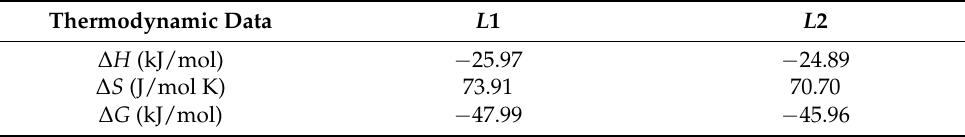
Figure 7. D U by two ligands in n-dodecane as a function of temperature ([HNO 3 ] ini = 5 mol/L, [U(VI)] ini = 10 g / L). Table 1. Thermodynamic data of L /n-dodecane extraction systems.